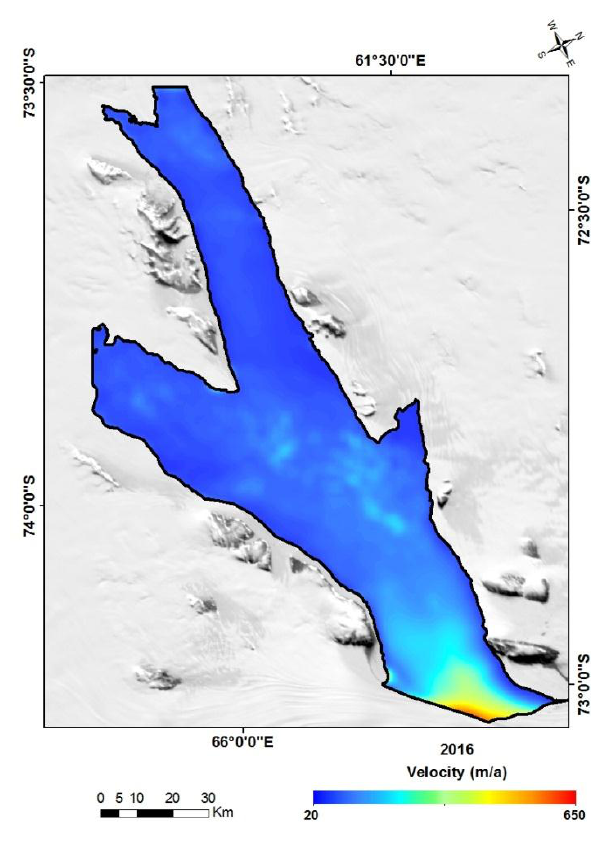
Figure 6: Estimated velocity of Fisher glacier in 2016.